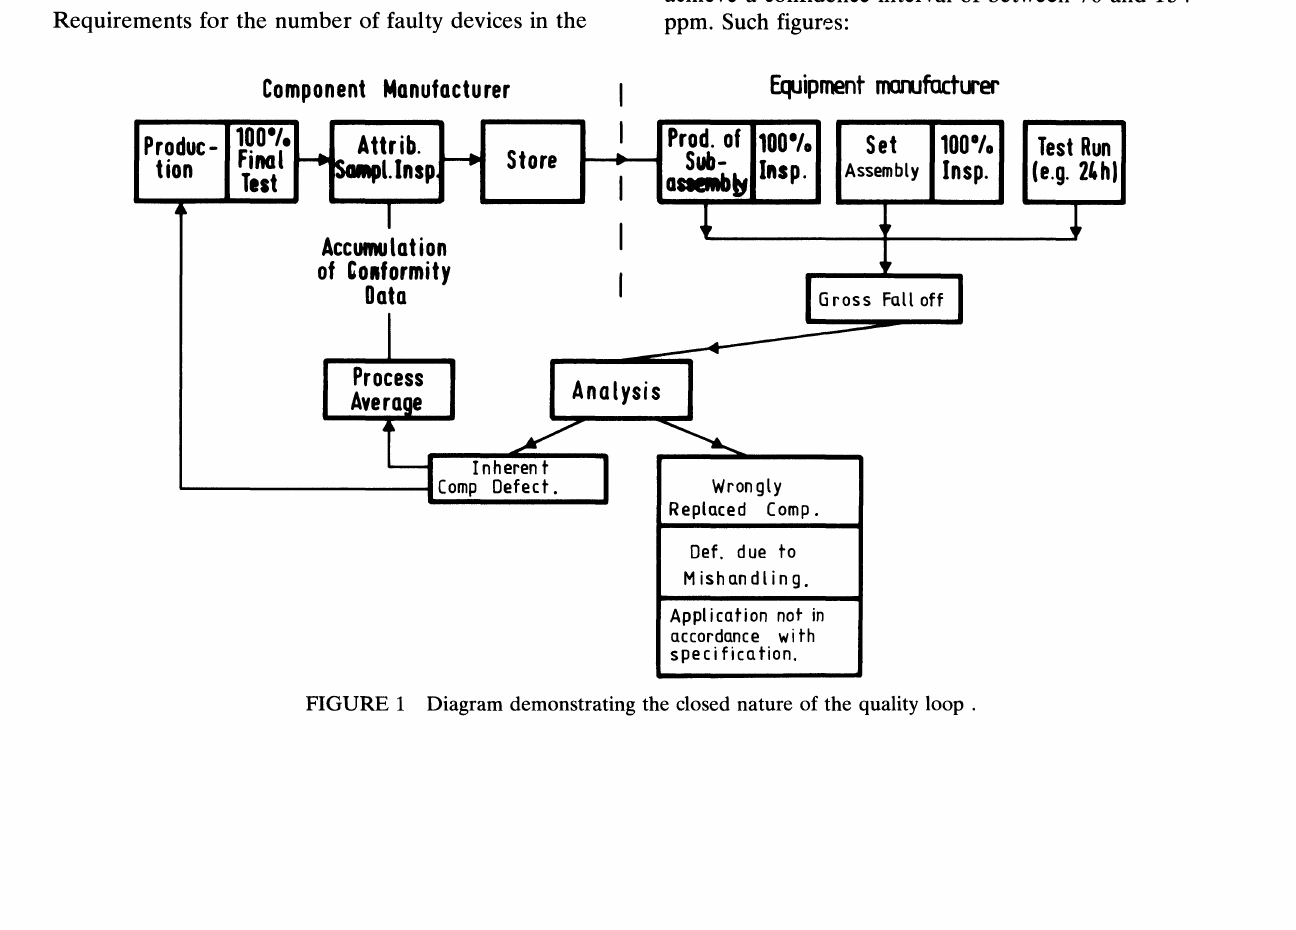
FIGURE 1 Diagram demonstrating the dosed nature of the quality